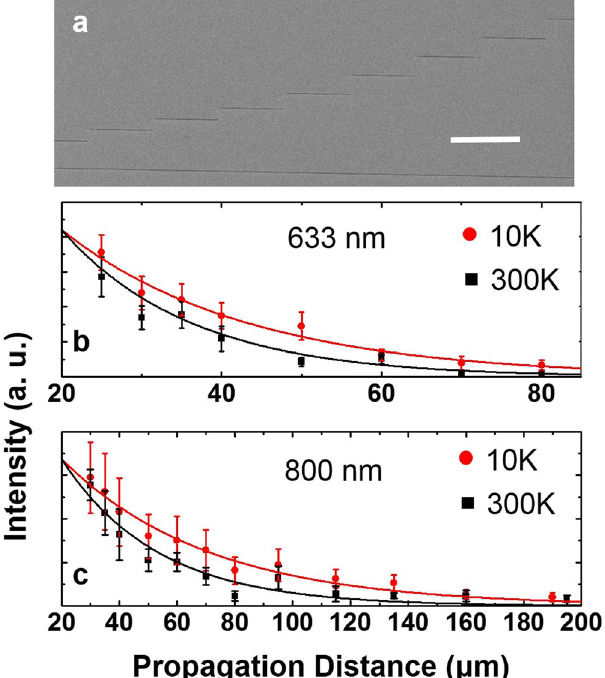
Figure 3. Propagation distance measurements from an MBE grown silver film. ( a ) SEM image of silver film grown with MBE method. Several short input slits are milled with FIB method. A long output slit is milled near the bottom. Scale bar is 20 μ m. Integrated output intensity as a function of distance for incident laser of wavelength at ( b ) 633 nm and ( c ) 800 nm. Black squares and red circles are experimental data from 300 K and 10 K, respectively. Solid lines are exponential